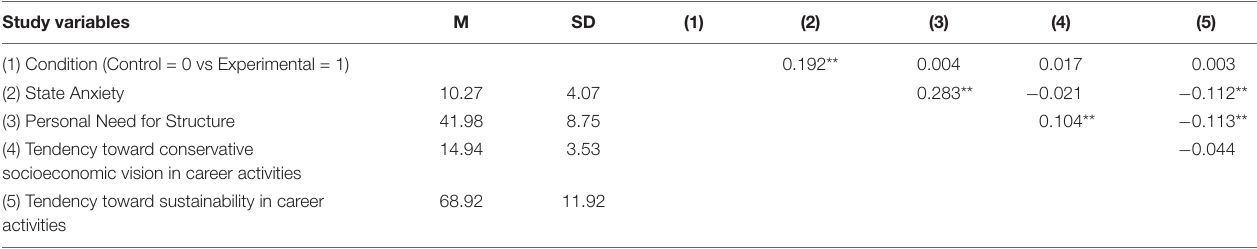
TABLE 1 | Means, standard deviations, and Pearson’s correlation. Study